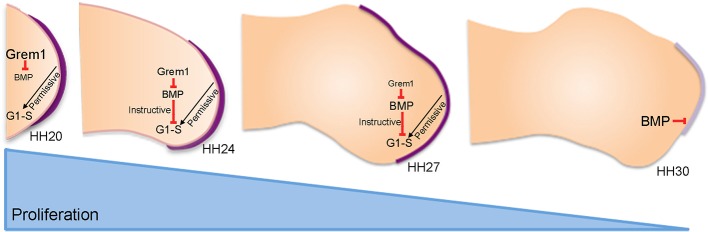
An intrinsic cell cycle timer terminates limb bud outgrowth.HH20-HH24: antagonism of BMP signalling by Grem1 permits rapid mesenchyme proliferation and maintenance of the apical ectodermal ridge (purple) that permissively supports outgrowth. HH24-HH27: intrinsic rise in BMP signalling counters BMP antagonism and instructively decelerates mesenchyme proliferation rate. HH27-HH30: mesenchyme proliferation diminishes as patterning completes at HH28 and then BMP signalling inhibits FGF signalling in apical ectodermal ridge that then regresses.